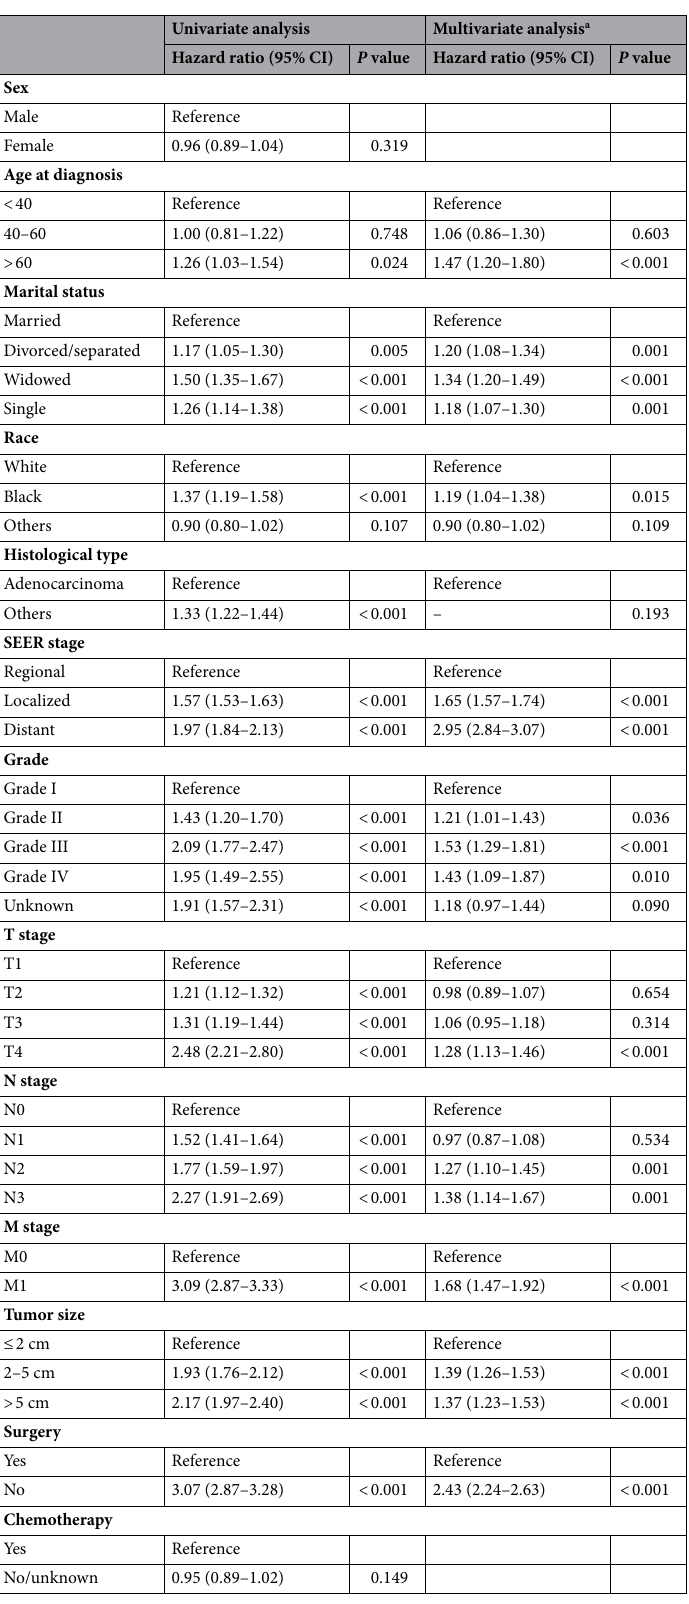
Table 2. Univariate and multivariate analysis of overall survival (OS) rates in the training cohort. OS overall survival, SEER surveillance, epidemiology, and end results. a Model was adjusted by age at diagnosis, marital status, race, histological type, SEER stage, grade, TNM stage, tumor size and